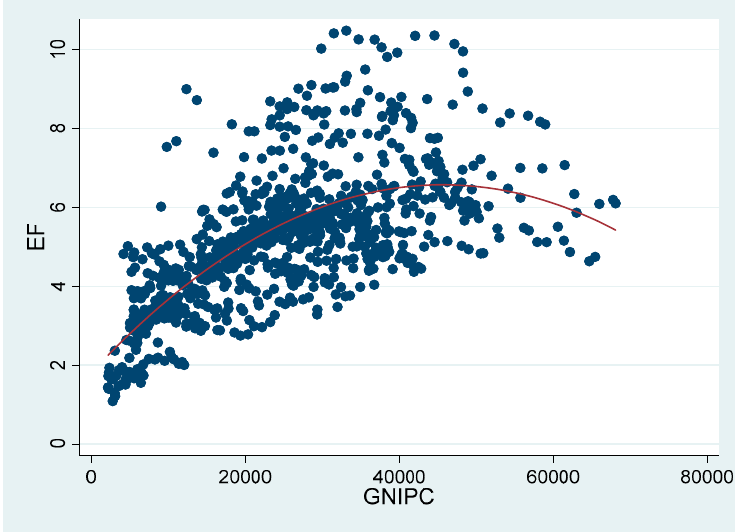
Figure 4. Scatter plot of EF and GNIPC of the developed countries.